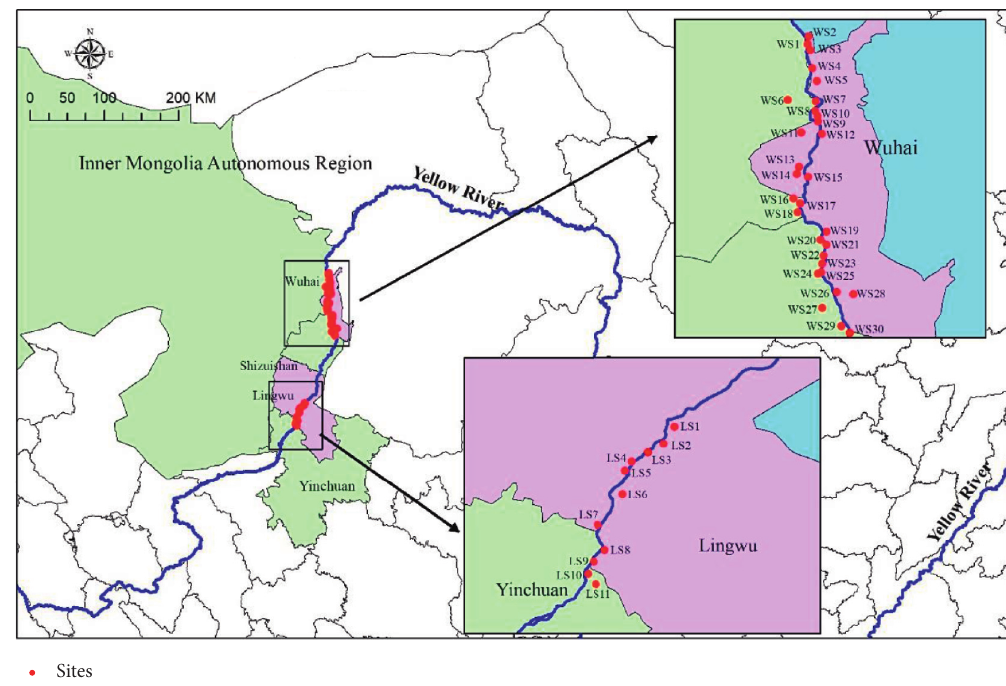
Figure 1: Schematic diagram showing the locations of the sampling sites in the Yellow